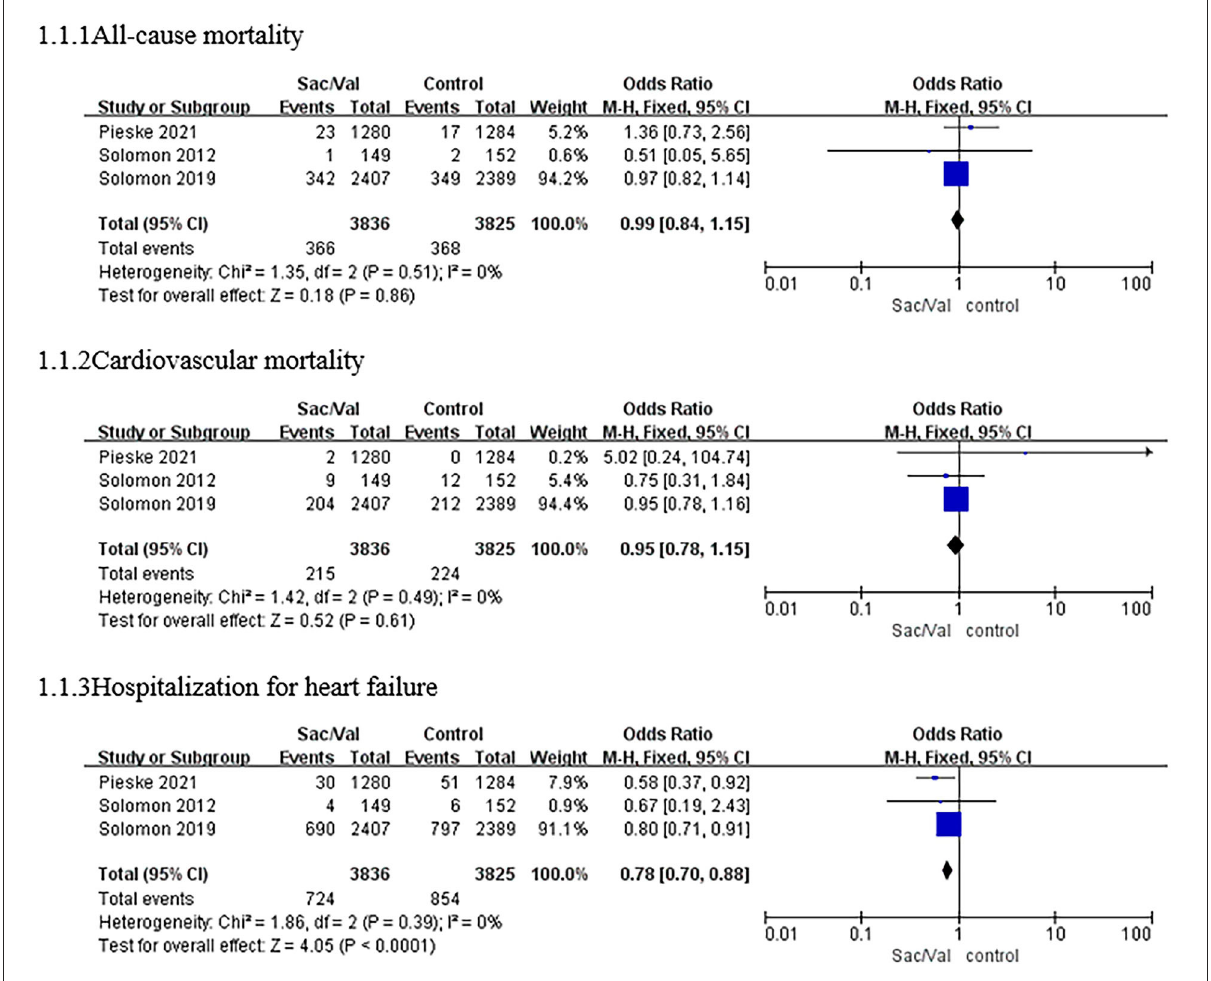
FIGURE2 A forest plot of the effective outcomes of all-cause mortality, cardiovascular mortality, and hospitalization for HF in different patients with HFpEF. HF, heart failure; HFpEF, heart failure with preserved ejection fraction; Sac/Val,